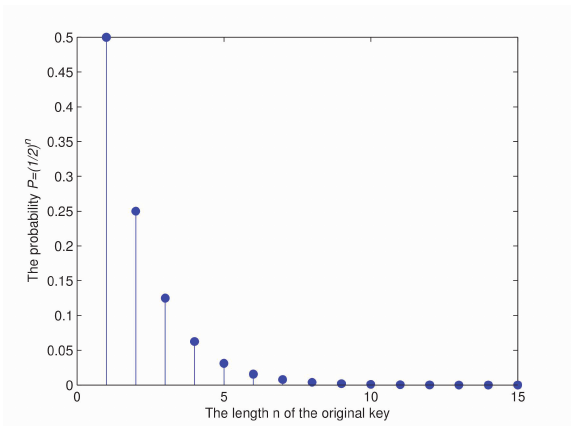
Figure 2. The probability that all bits of the original key are 0 or 1 as a function of the length of the original key. It shows that the larger n is, the smaller probability is. Such as n is greater than 10-bit, ) n approaches to the probability of P = ( 1 2